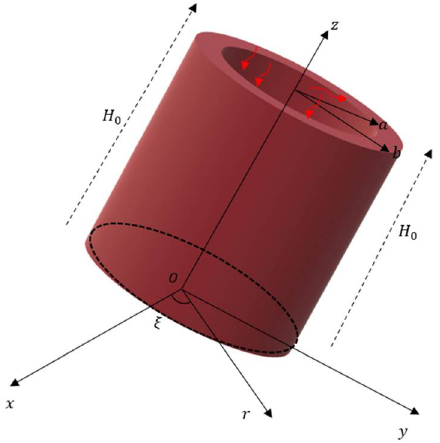
Figure 1. Diagrammatic representation of thermoelastic hollow cylinder.